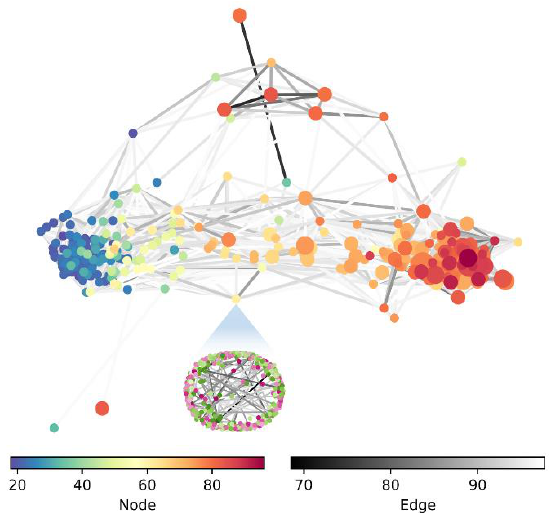
Figure 11. Network of SHAP interaction networks. Each node represents a SHAP interaction network of a subject (below the figure is an example of the network corresponding to a node), and the two color bars represent the age of the node and the connection strength of the edge (black represents high strength), respectively. The size of the dots from small to large indicates the subject’s four levels of dementia, which are no dementia, very mild dementia, mild dementia, and moderate dementia.